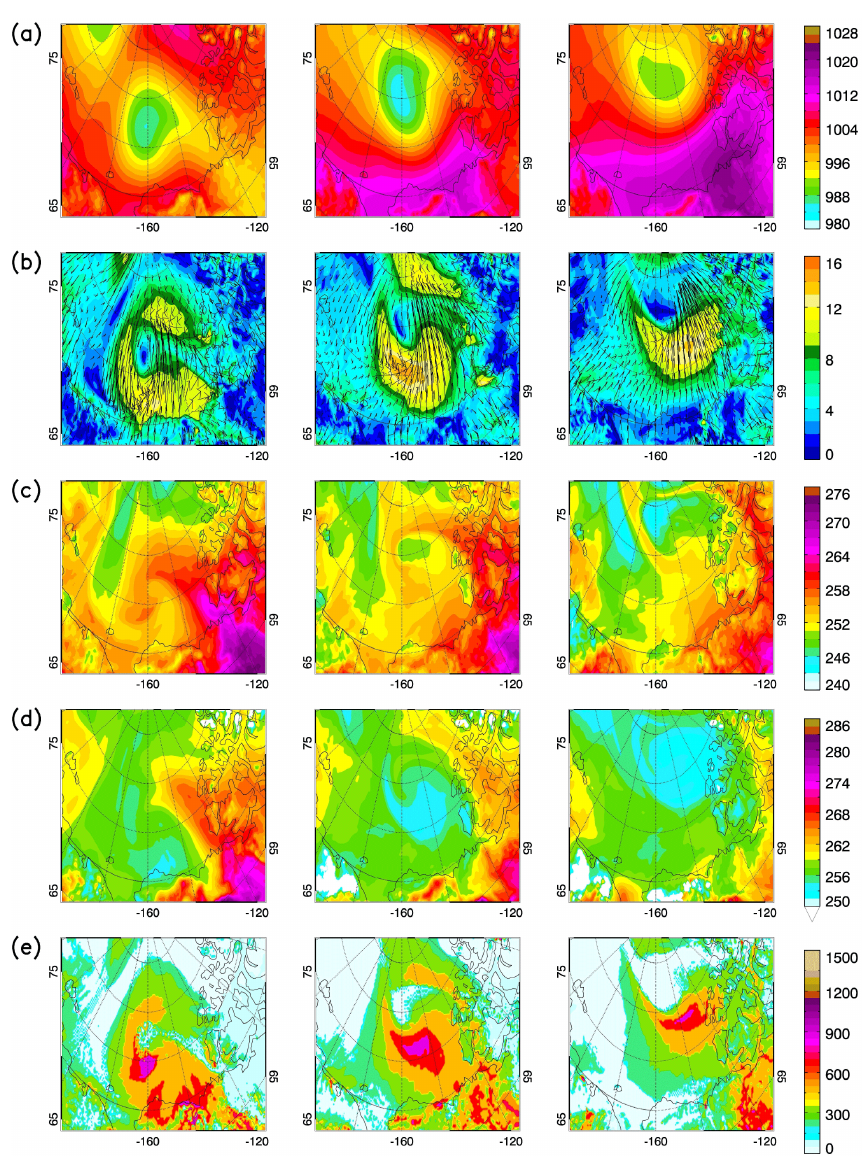
Figure 4. WRF weather simulations of the BCTE for (a) sea level pressure [hPa], (b) wind direction (black arrows) and wind speed [ms − 1 ] (coloured shadings), (c) temperature [K] at 2m above ground, (d) temperature [K] at 350gpm (note that the colour bar differs for c and d ) and (e) planetary boundary layer height [m]. Shown from left to right are simulations for different development stages of the BCTE: onset (31 March 2011 at 23:30UTC), mature stage (1 April 2011 at 21:30UTC) and dissolving stage (2 April 2011 at